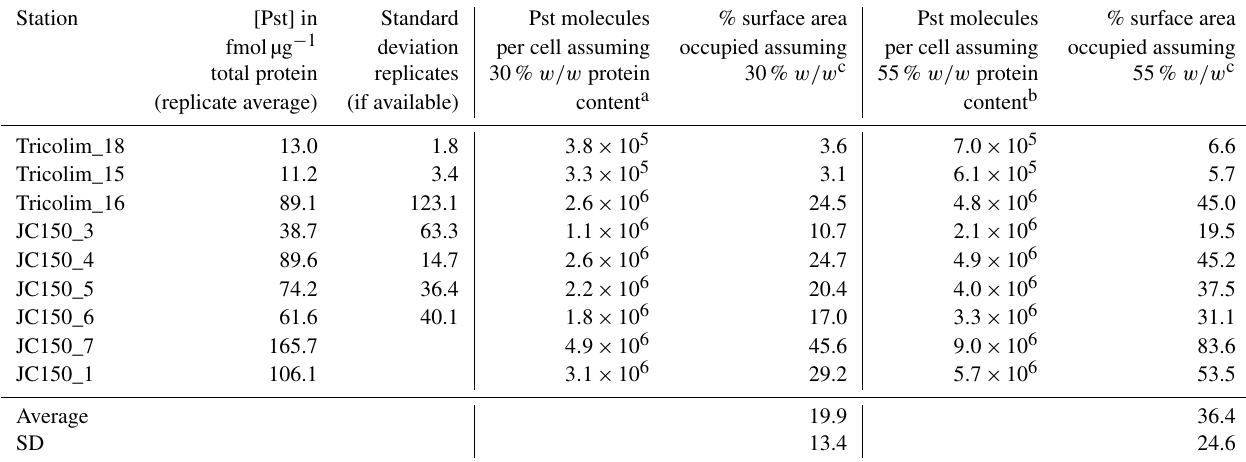
Table 1. Quantification of the ABC transporter PstA and estimation of membrane space occupied. Station